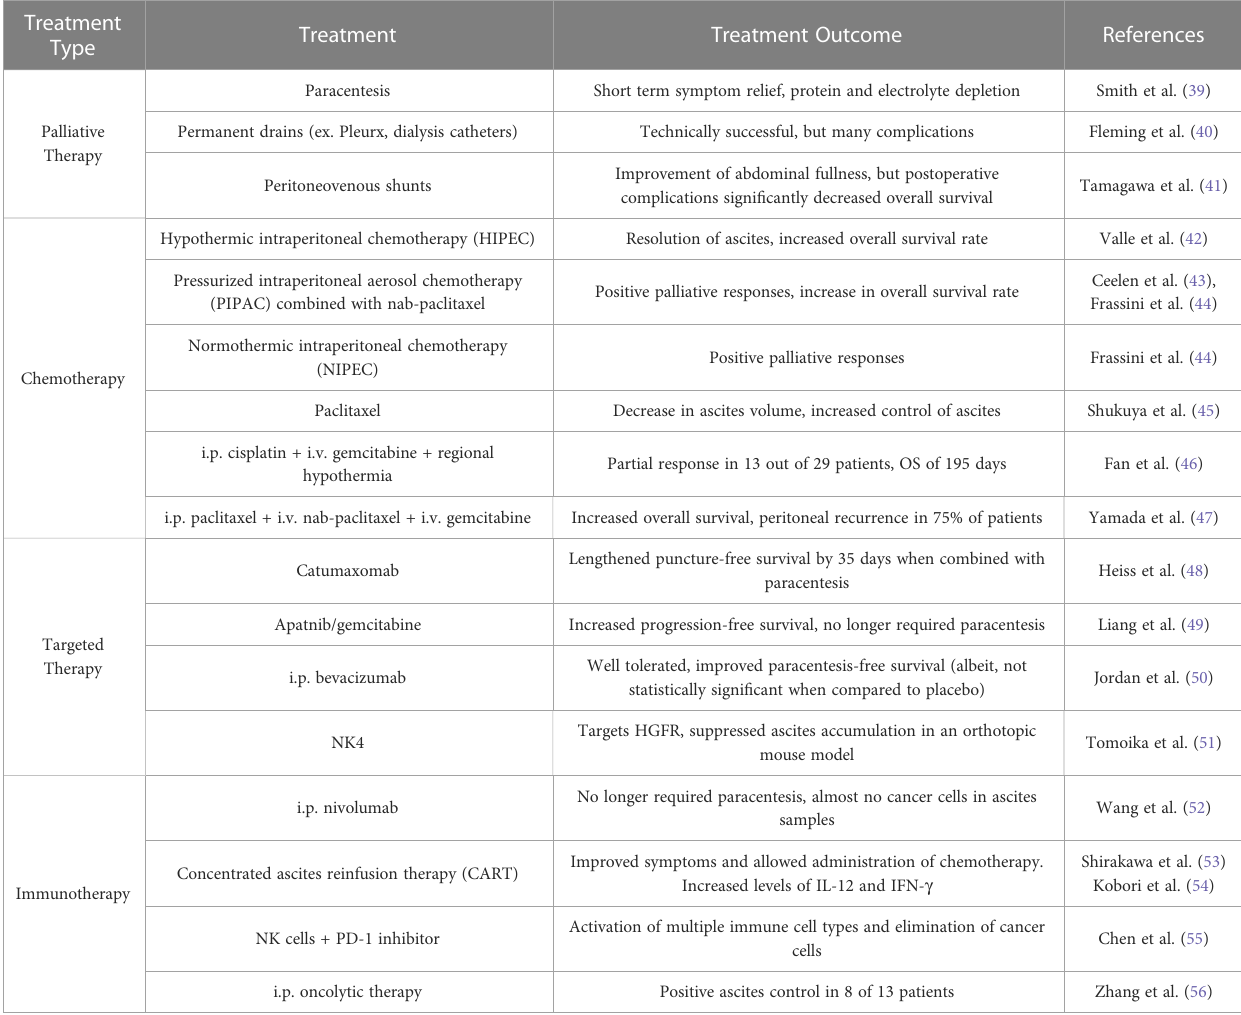
TABLE 1 Treatment options and their outcomes for MA in patients with